Question: Sum up the contents of this chart in one sentence.
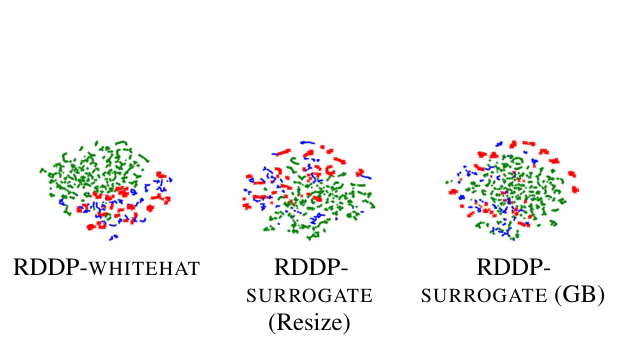
Answer: Frame distributions. Green +, blue ◦, red × repre- sents frame sampled from Dgen, Drecon, Dforged for RDDP- WHITEHAT and Dgen, A ◦Dgen, A ◦Dforged for RDDP- SURROGATE (Resize and GB). The mixture of blue ◦and red × being separate from the green + cluster in each plot demonstrates RDDP reducing the distribution shift between genuine and forged examples.